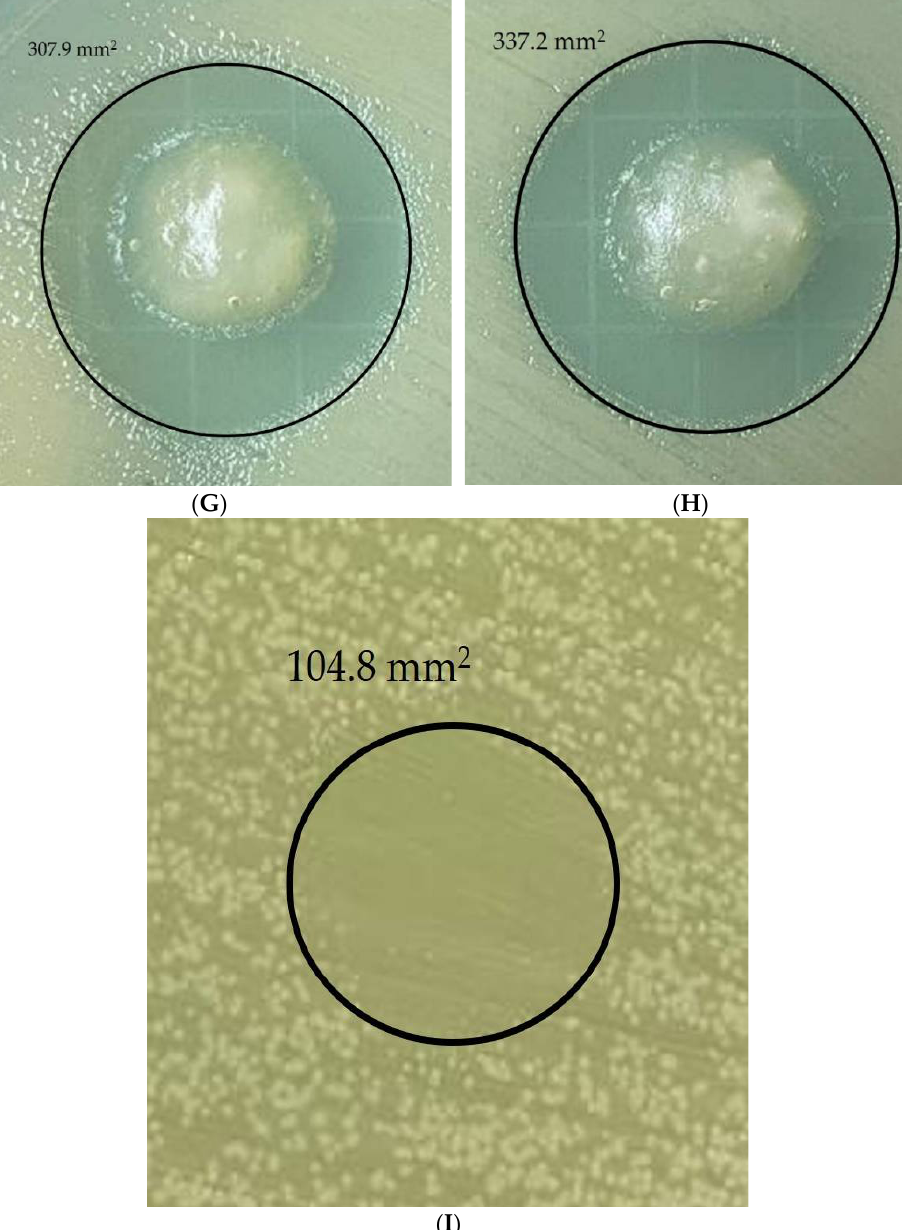
Figure 6. A study of the antibacterial activity of different formulations of starch-based wound-dressings against E. coli ( A ) 0.46 wt% CA, ( B ) 0.92 wt% CA, ( C ) 1.38 wt% CA, ( D ) 1.83 wt% CA and against S. aureus ( E ) SPGC1, ( F ) SPGC2, ( G ) SPGC3, ( H ) SPGC4), ( I ) control zone.